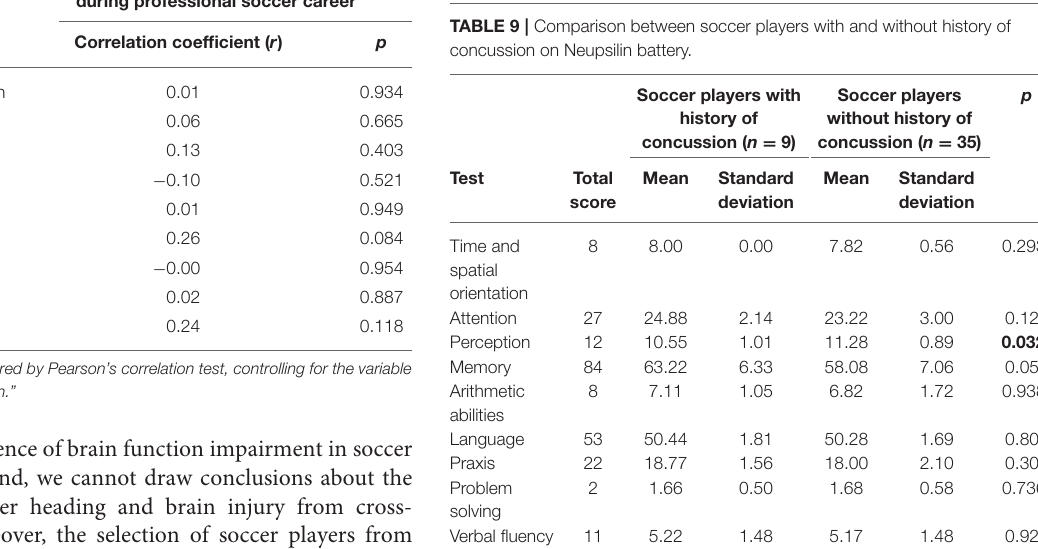
TABLE 7 | Correlations between performance of soccer players on Neupsilin battery and estimate of exposure to heading during professional soccer career. Estimate of exposure to heading during professional soccer career